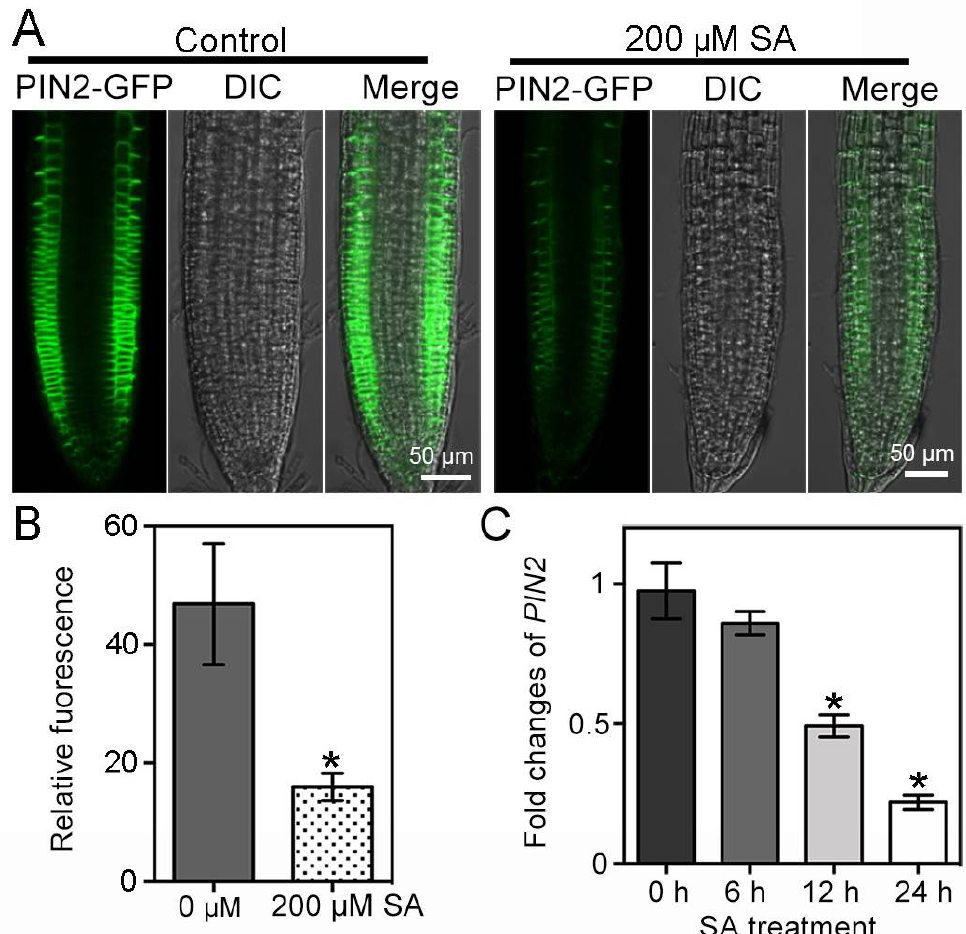
Figure 3. Effects of high-concentration SA on PIN2 accumulation and PIN2 expression. ( A , B ) PIN2 accumulation in the roots of transgenic ProPIN2: PIN2-GFP seedlings. Five-day-old ProPIN2: PIN2-GFP seedlings were treated with 200 µ M SA for 2 days. PIN2-GFP signal was measured in the roots (n = 4). ( C ) qRT-PCR analysis of PIN2 expression in wild-type Arabidopsis (Col-0) seedlings. Sever-day-old seedlings were transferred to 200 µ M SA-containing 1 / 2 MS medium and cultured for 0 h, 6 h, 12 h and 24 h, respectively. Scale bar = 50 µ m. Error bar = standard deviation (SD). p -values were determined with two-tailed Student’s t -test assuming equal variances (* p < 0.05).